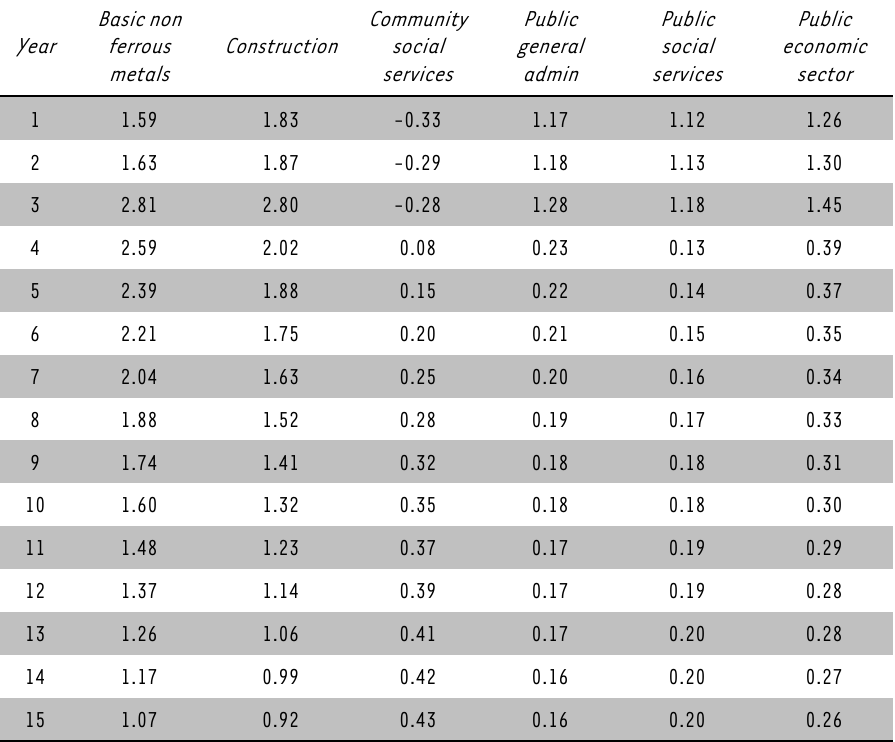
TABLE 2: Change in output for mixed financing scenario, selected sectors (% change from BAU) Basic non Year ferrous metals